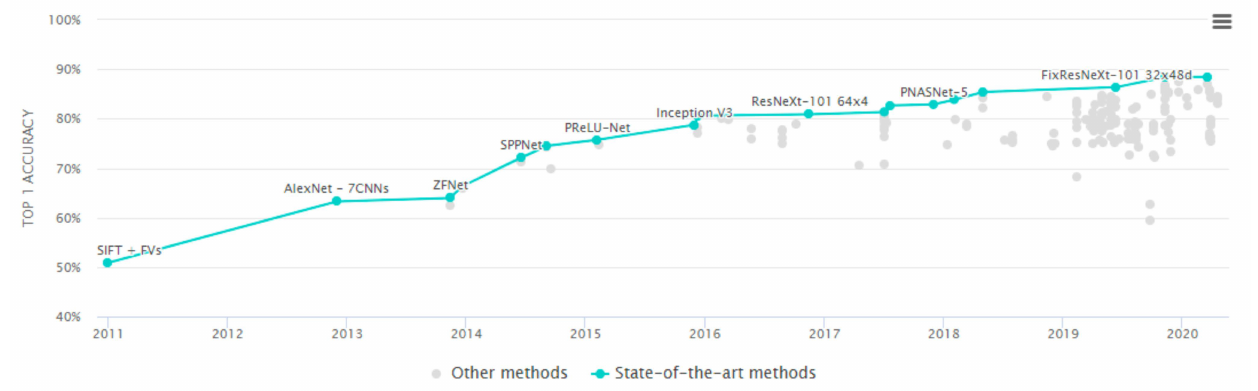
Figure 5. ImageNet Challenge Leaderboard from 2011 to